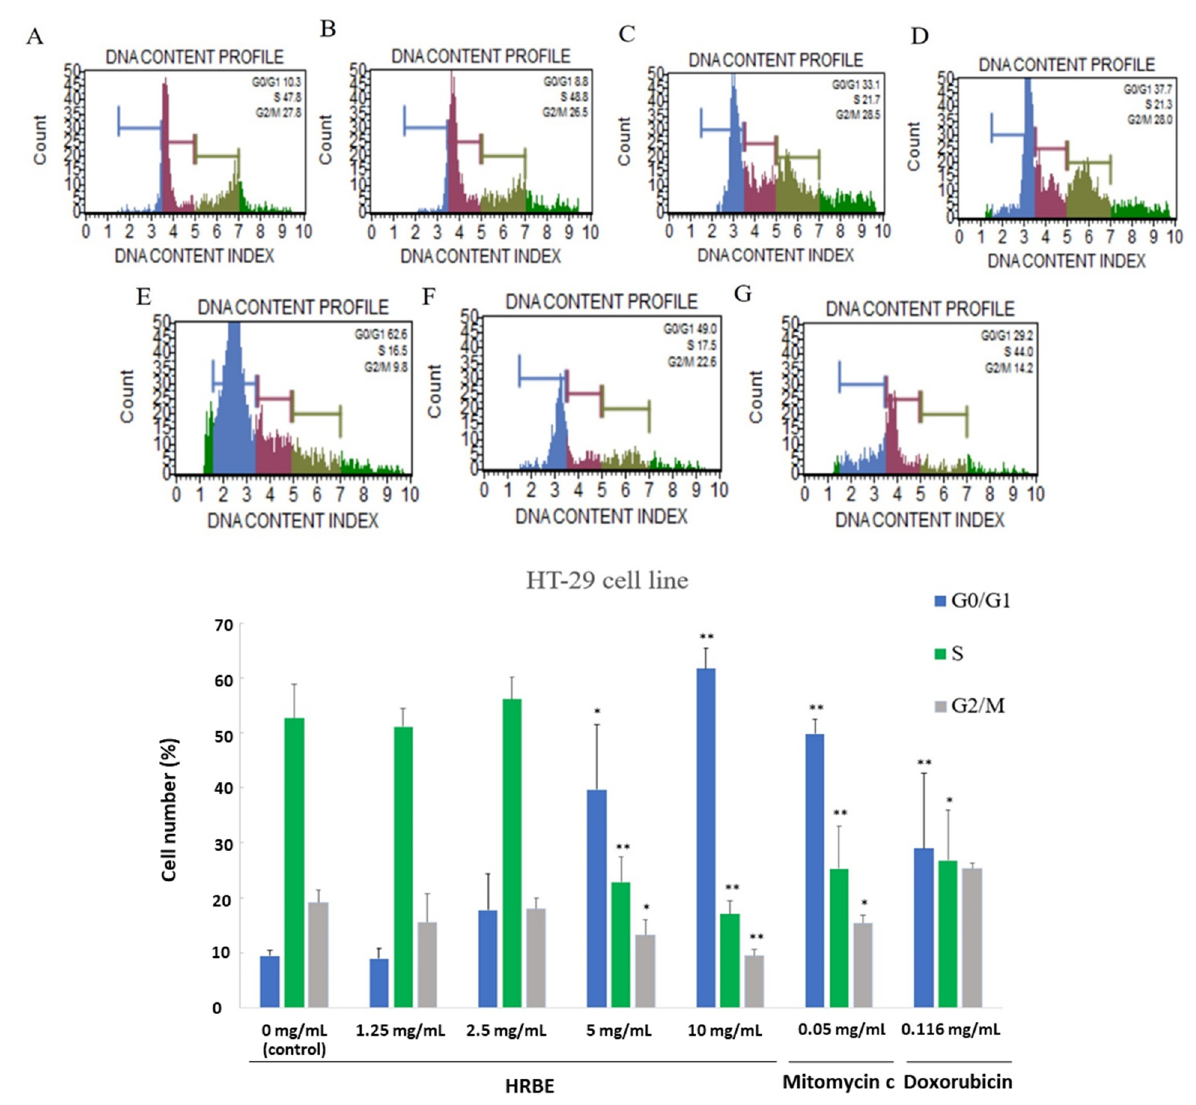
Figure 7. The cell cycle analysis by flow cytometer of HT-29 cells at 24 h after treatment with HRBE concentration 0 mg/mL, considered as negative control ( A ), 1.25 mg/mL ( B ), 2.5 mg/mL ( C ), 5 mg/mL ( D ) and 10 mg/mL ( E ) compared to positive control groups treated with 0.05 mg/mL mitomycin C ( F ) and doxorubicin 0.116 mg/mL ( G ). Data are represented by the mean ± SD. Statistical